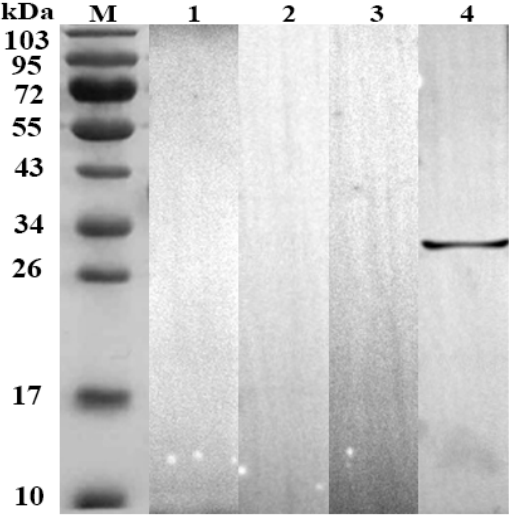
Figure 2. Western blot analysis of rHc-HCA59 antigen to determine cross-reactivity. Lanes shown are as follows: M = standard protein pre stain molecular weight marker; Lane 1: membrane incubated with positive T. gondii serum; Lane 2: membrane incubated with positive F. hepatica serum; Lane 3: membrane incubated with positive T. spiralis serum; Lane 4: rHc-HCA49 was recognized by goat anti- H. contortus sera (positive